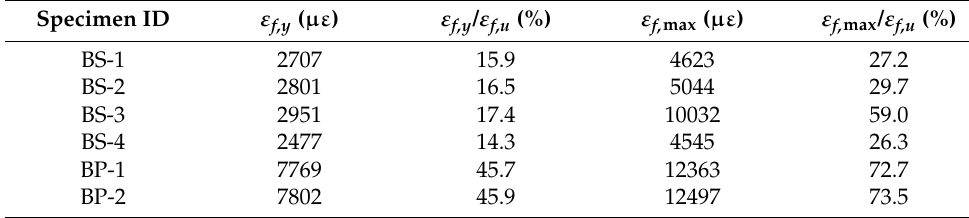
Table 5. Comparisons of CFRP strains at typical loading